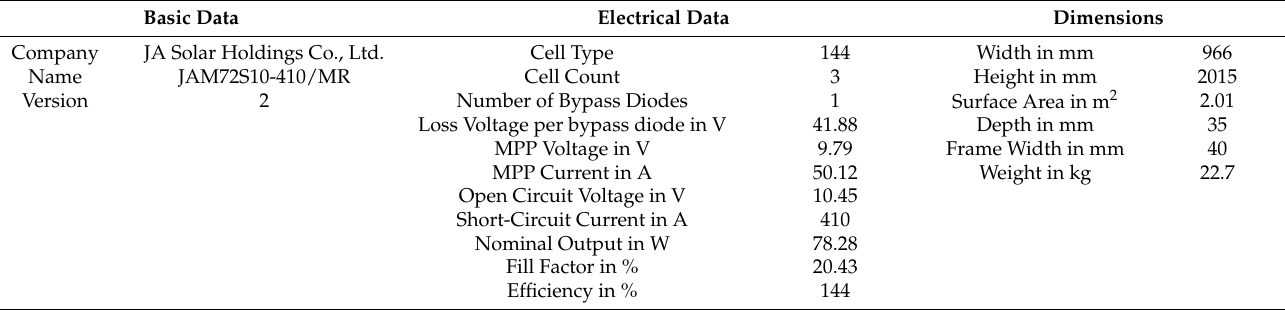
Table 2. Specifications of the used PV panels (JAM72S10-410/MR